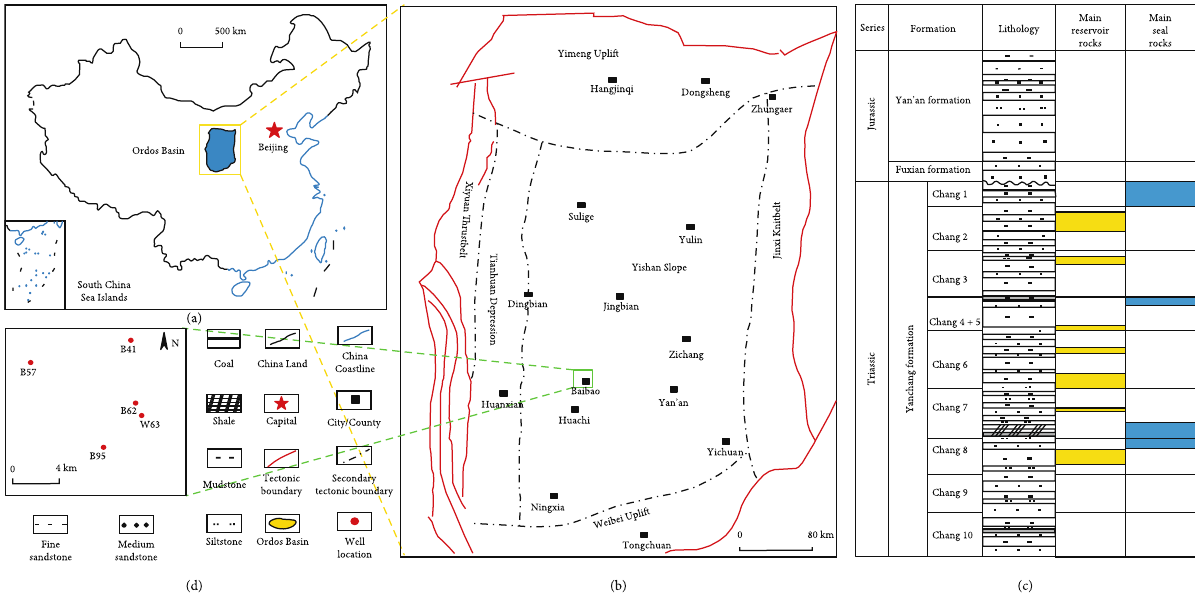
Figure 1: Study area structure and sampling location map (modi fi ed from [18]). (a) A map of China. (b) Location map of the study area. (c) The lithology column. (d) Sampling wells ’ relative location map.